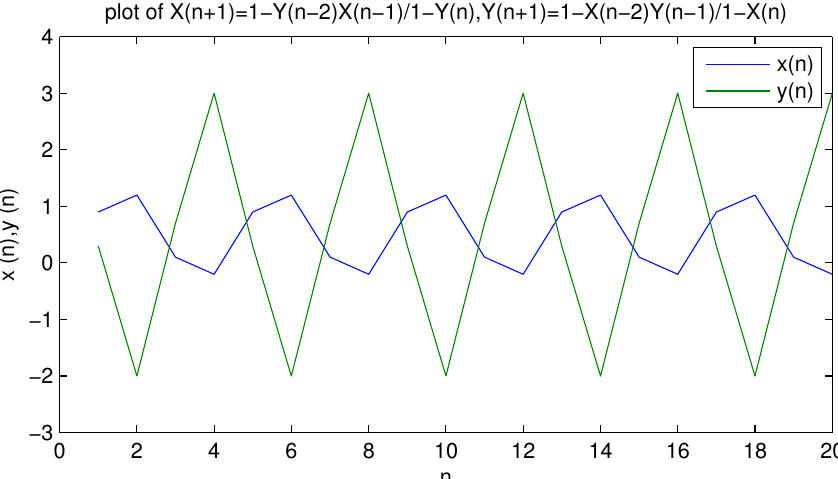
Figure 4. Plot of solutions of System (4) when the initial conditions are x − 2 = 0.9, x − 1 = 1.2, x 0 = 0.1, y − 2 = 0.3, y − 1 = − 2 and y 0 = 0.7.